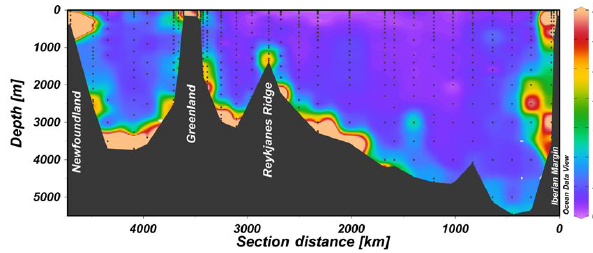
Figure 7. Section plot of particulate Al along the GEOVIDE sec- tion. For station numbers, please refer to Fig. 6. Data are from Gourain et al.